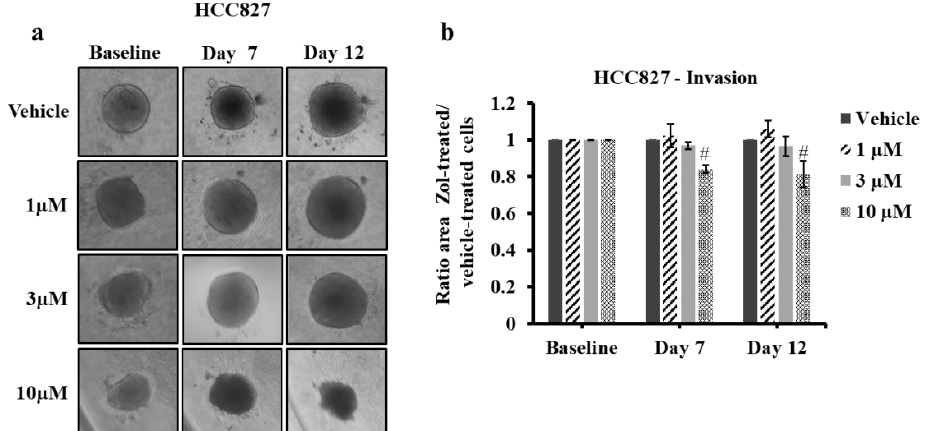
Figure 6. Spheroid invasion assay of HCC827 cells treated with vehicle (PBS1x) or Zol 1 µM, 3 µM and 10 µM for 7 and 12 days in 1% serum conditions. ( a ) Representative brightfield images of HCC827 spheroid invasion/growth within the invasion matrix from vehicle or Zol-treated conditions. ( b ) Histograms for invasion/growth in the matrix showing the mean of three independent experiments ± SD. Each condition (drug-treated cells or vehicle-treated cells) on each day was normalized to day 0 and then to vehicle. Close to be significantly different from control # p ≥ 0.05.